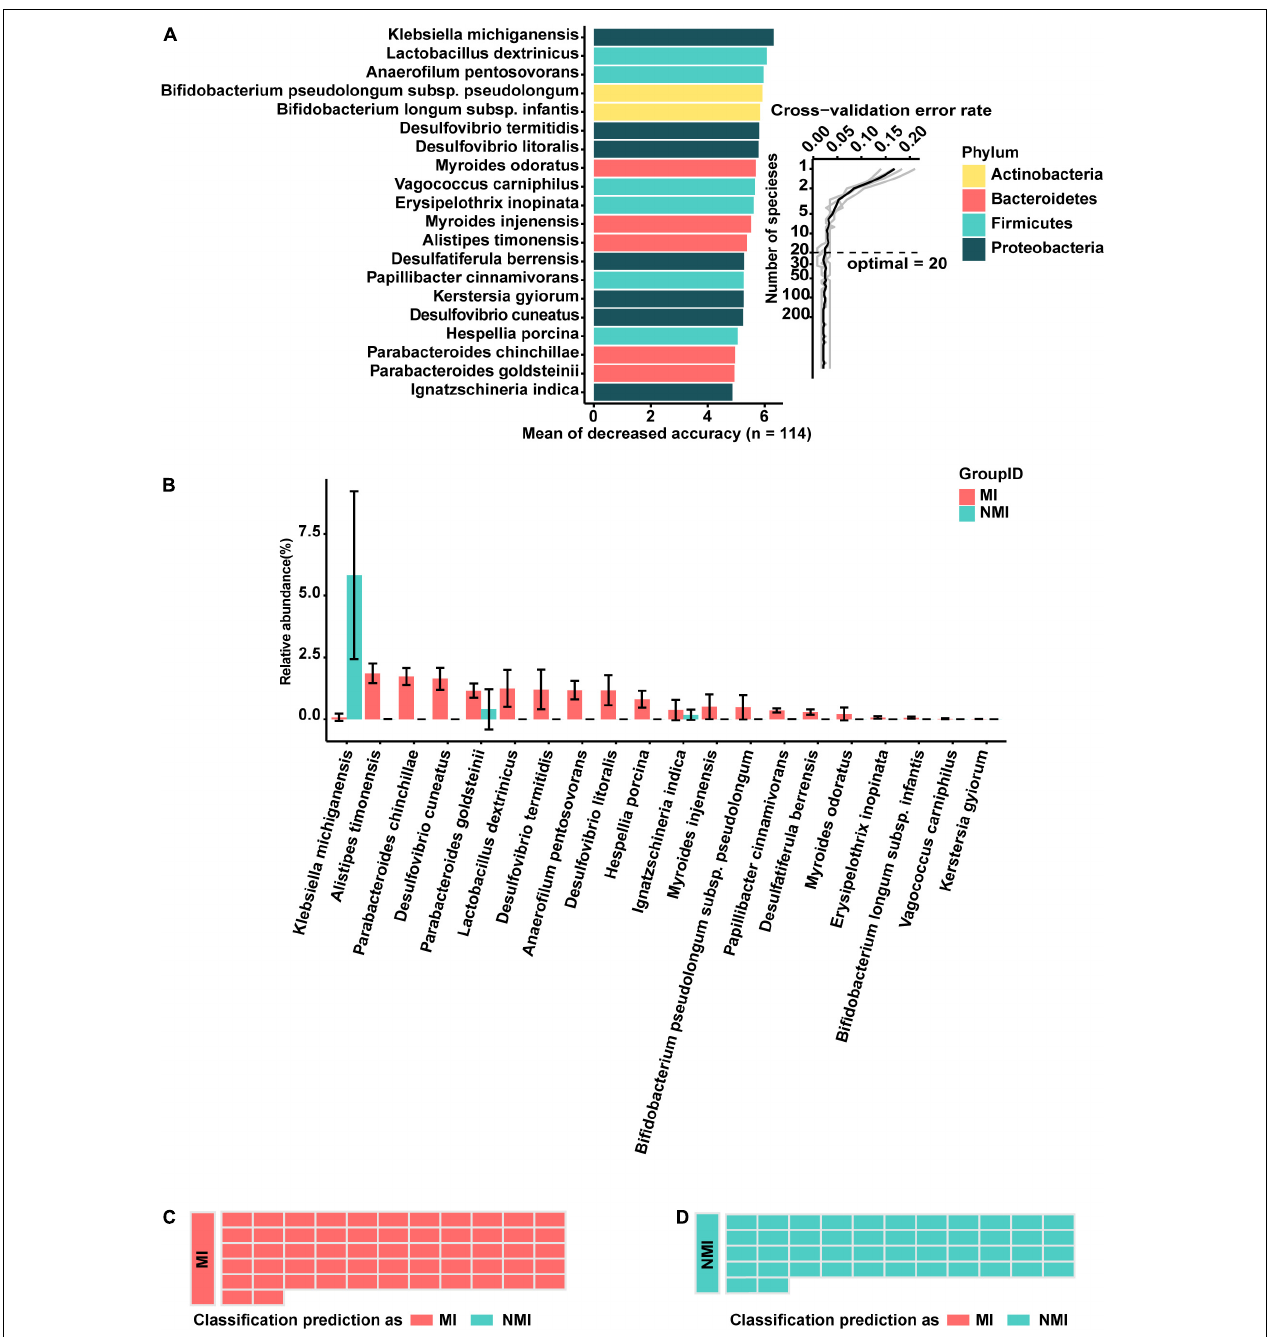
FIGURE 3 | A random-forest model based on gut microbiota to predict medicinal insects. (A) The top 20 most important biomarkers identified by random-forest classification in the medicinal insect and the non-medicinal insect group, with the biomarker taxa ranking in descending order of importance in terms of model accuracy. The inset indicated the ten-fold cross-validation error rate. (B) Relative abundance (%) of marker bacteria in the medicinal insect group (MI) and the non-medicinal insect group (NMI). The gut microbiota of medicinal insects was indicated in red and blue represented the gut microbiota of non-medicinal insect. The heights of columns represented means, and error bars represented standard errors. (C) Prediction results of the gut microbiome of MI using the model obtained with the training samples. Sample groups are shown on the left side of the diagram. The predicted groups are shown on the right. The samples in (C) belong to the medicinal insect group, red indicates that the samples are predicted to be medicinal insects, and blue indicates that the samples are predicted to be non-medical insects. (D) Prediction results of the gut microbiome of NMI using the model obtained with the training samples. Sample groups are shown on the left side of the diagram. The predicted groups are shown on the right. The samples in (D) belong to the non-medical insect group, red indicates that the samples are predicted to be medicinal insects, and blue indicates that the samples are predicted to be non-medical insects.